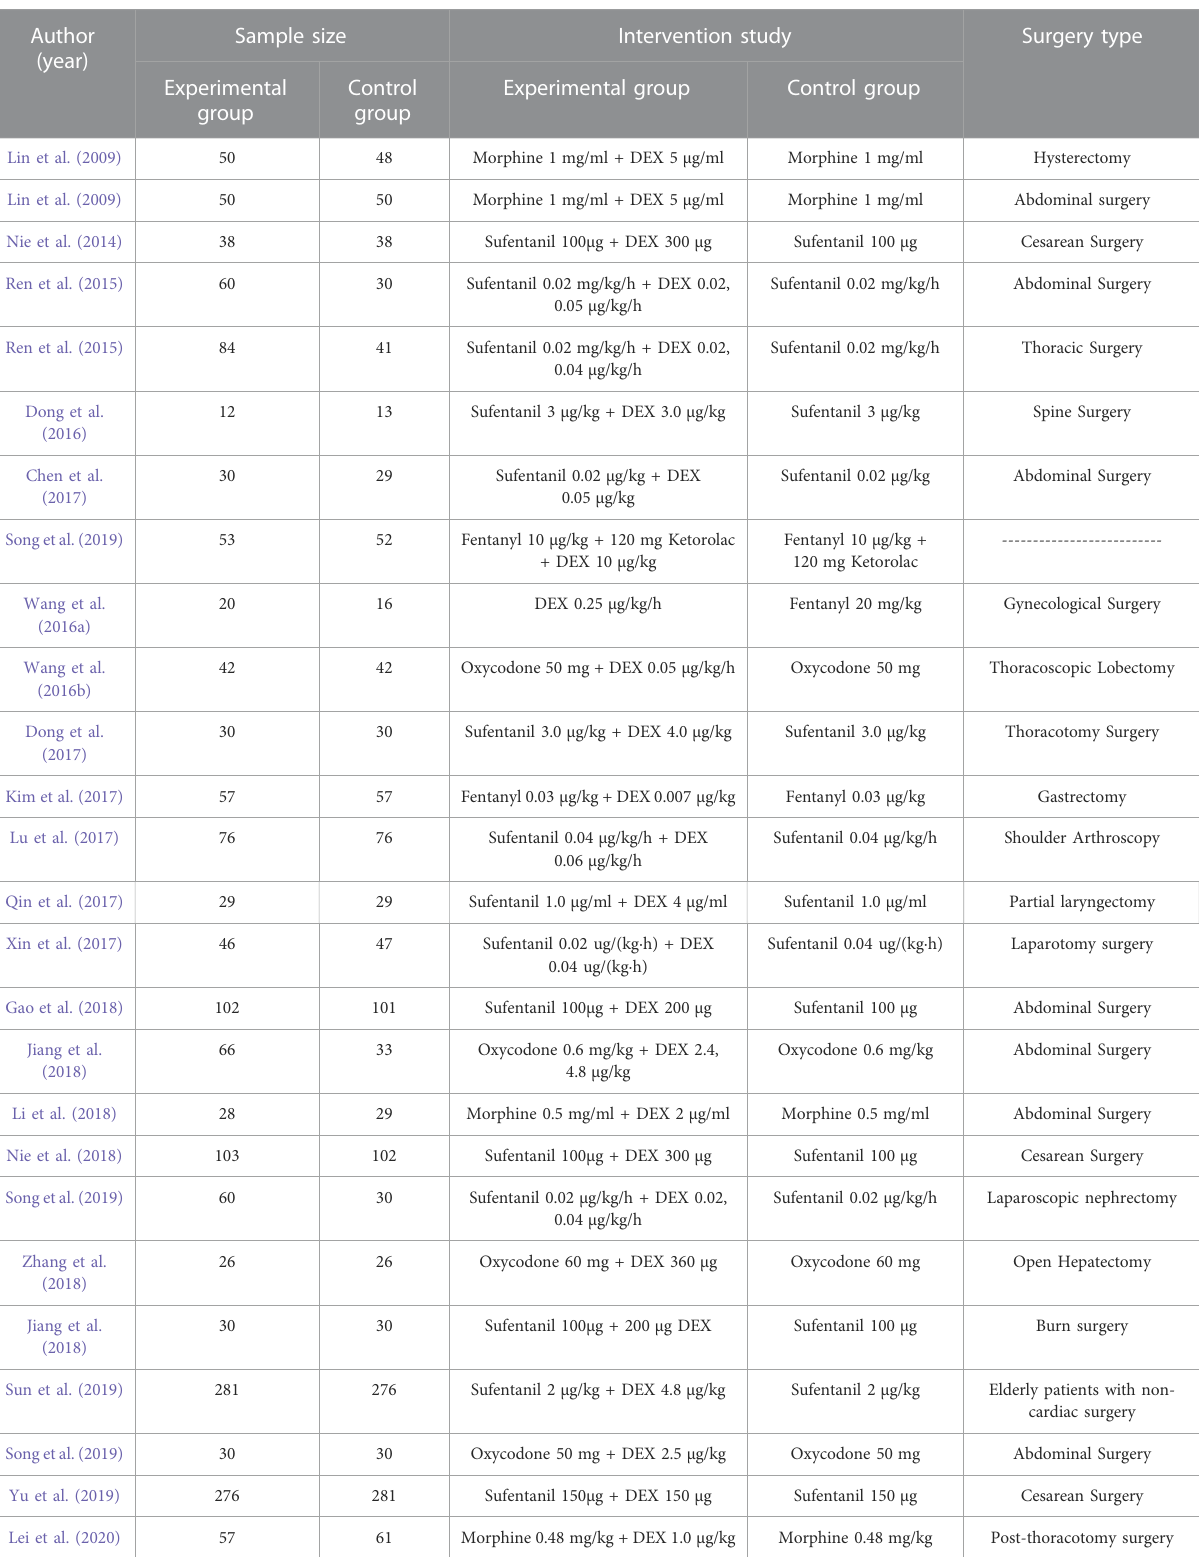
TABLE 1 Characteristics of included